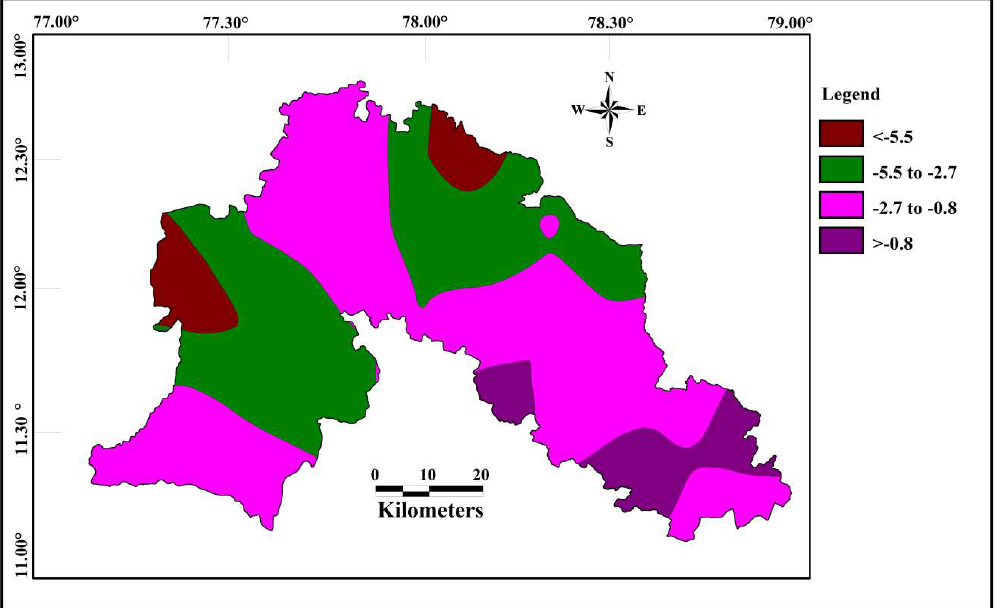
Figure 9. Spatial distribution of δ 18 O in the groundwater (in permil).